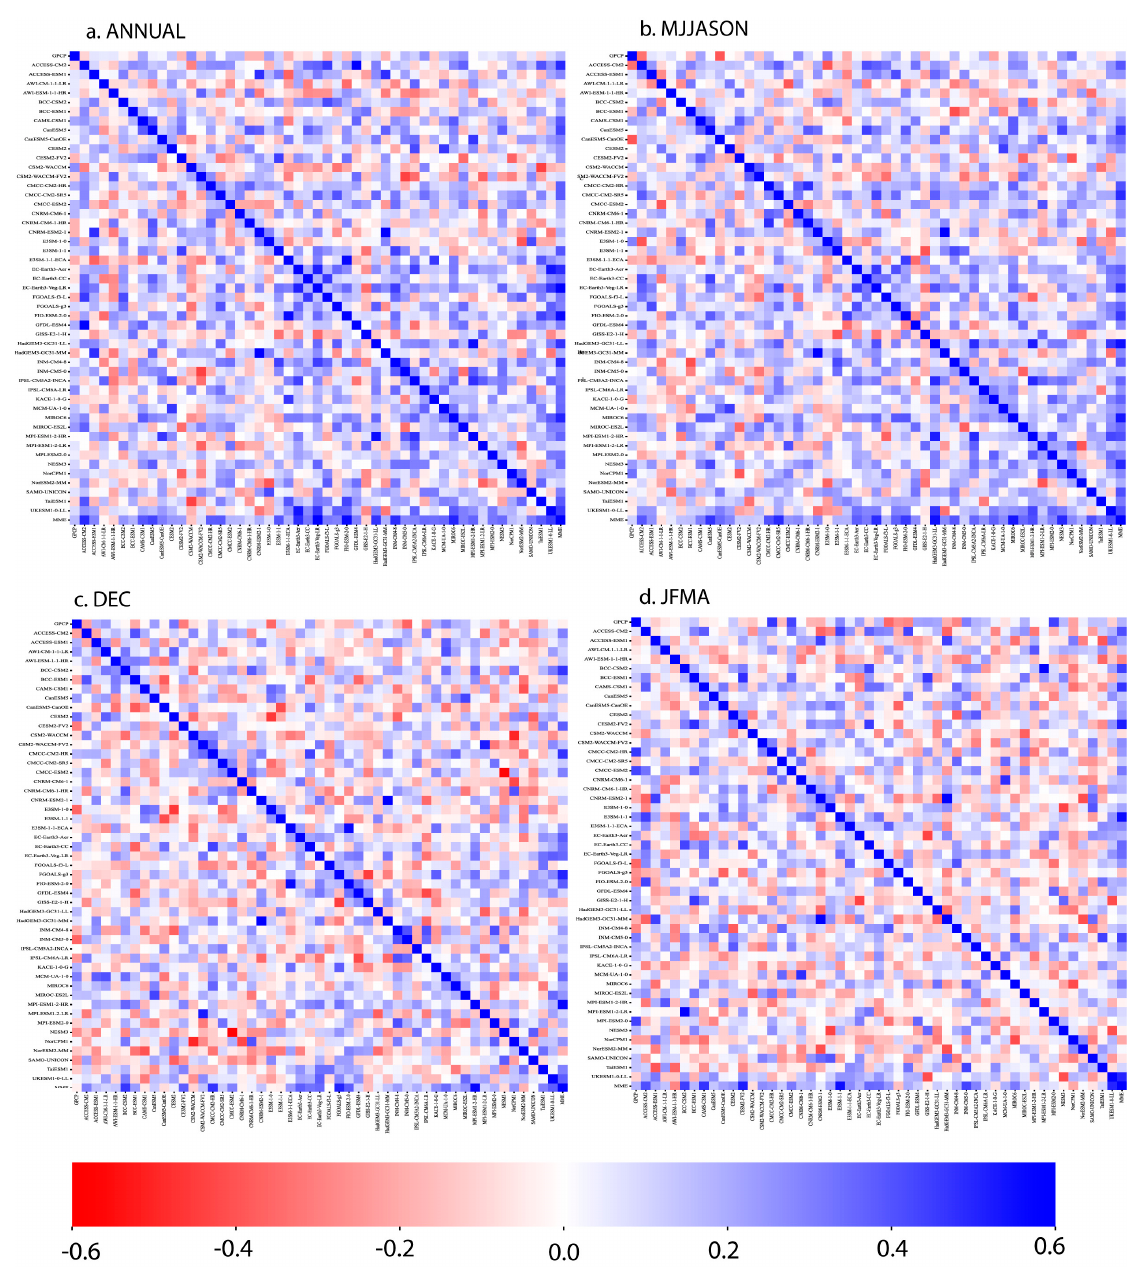
Figure 8. Heatmap plots comparing correlation coefficients of mean precipitation between GPCP and 49 GCMs and their ( a ) annual, ( b ), MJJASON, ( c ) December, and ( d ) JFMA MME during 1980–2014.